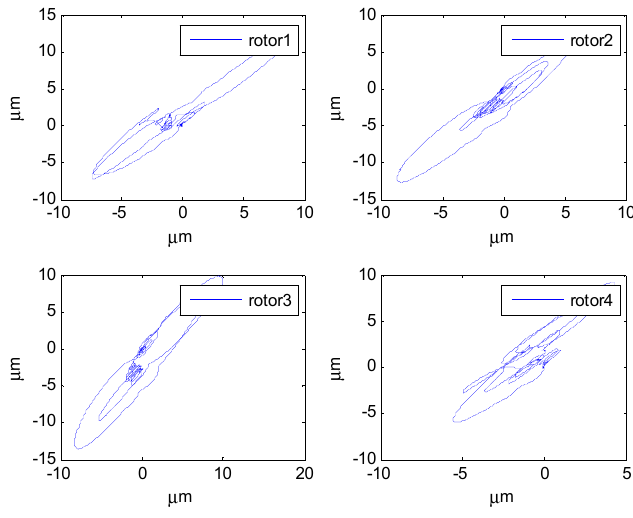
Figure 14. The rotor displacement without feedforward compensation.